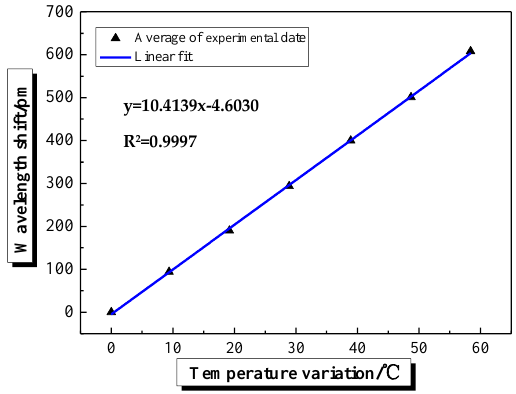
Figure 3. The curve of temperature response.